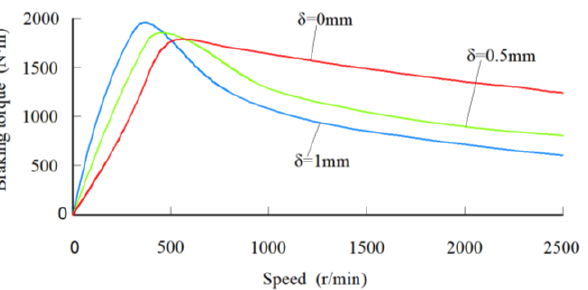
Figure 5. Relationship curves of copper coating thickness, rotor drum speed, and braking